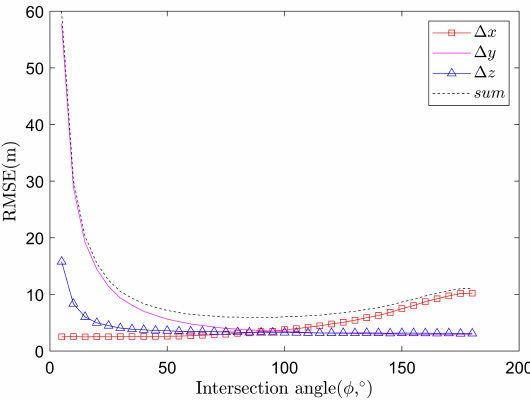
Figure 7. Relationship between localization error and intersection angle φ